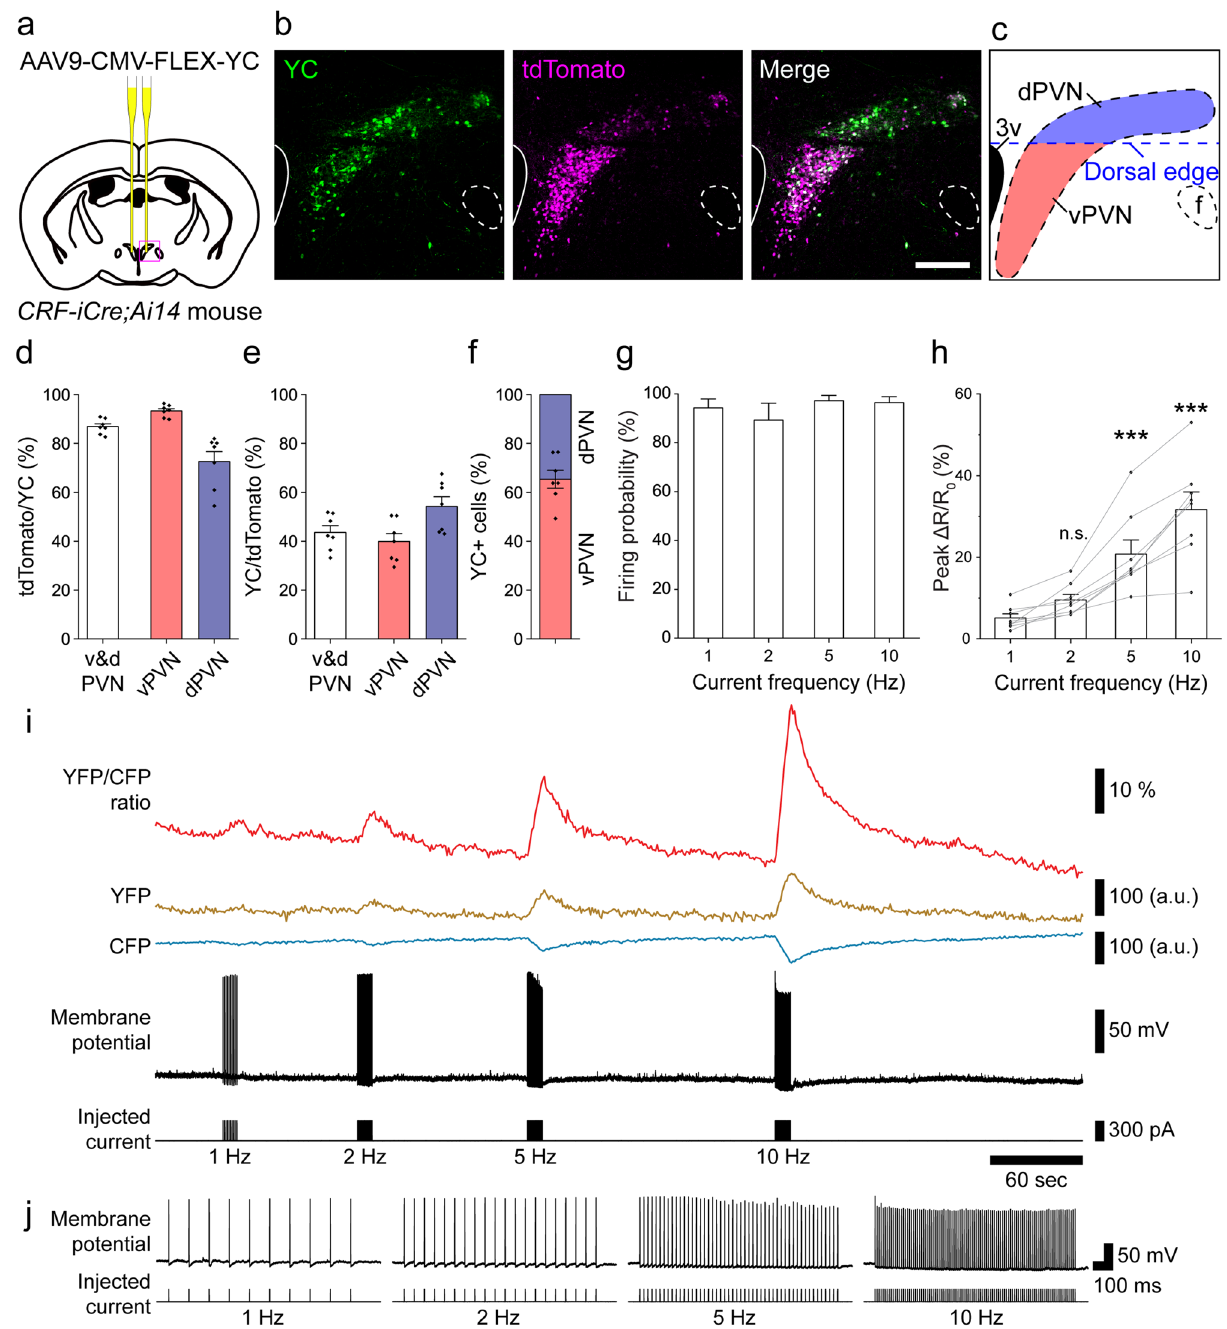
Figure 1. Expression and function of YC in PVN-CRF neurons. ( a ) Injection position of AAV9-CMV- FLEX-YC in the brain. ( b ) Expression of YC in PVN-CRF neurons of CRF-iCre;Ai14 mice. Green: YC, magenta: tdTomato, scale bar: 200 μm. ( c ) Schematic diagram of the ventral (red) and dorsal (blue) PVN (vPVN and dPVN, respectively) in ( b ). The blue dotted line indicates the mediolateral line through the dorsal edge of the third ventricle which defines the boundary between the vPVN and dPVN. 3v third ventricle, f fornix. ( d ) Percentage of tdTomato-expressing (tdTomato + ) cells among the YC-expressing (YC + ) cells in the v&d PVN, vPVN or dPVN, where v&d PVN indicates the entire PVN. ( e ) Percentage of YC + cells among the tdTomato + cells in the v&d PVN, vPVN or dPVN, where v&d PVN indicates the entire PVN. ( f ) Occupancy of YC + cells in the vPVN and dPVN within the entire PVN. ( g ) Probability of action potentials induced by pulse current injection. ( h ) Summary of peak ΔR/R 0 for pulse current injection-induced action potentials. Statistical analysis was performed using a Kruskal–Wallis test followed by Dunn’s test vs. 1 Hz (***p < 0.001; n.s., not significant). ( i ) Representative trace from simultaneous recording of the calcium signal and membrane potential. Command current was injected through a patch pipette. The frequencies of the injected currents are indicated below the trace. ( j ) Magnified trace of each current injection-induced firing. The frequencies of the injected currents are indicated below the trace. Bar graphs, error bars and dots show the mean value, standard errors and individual data,